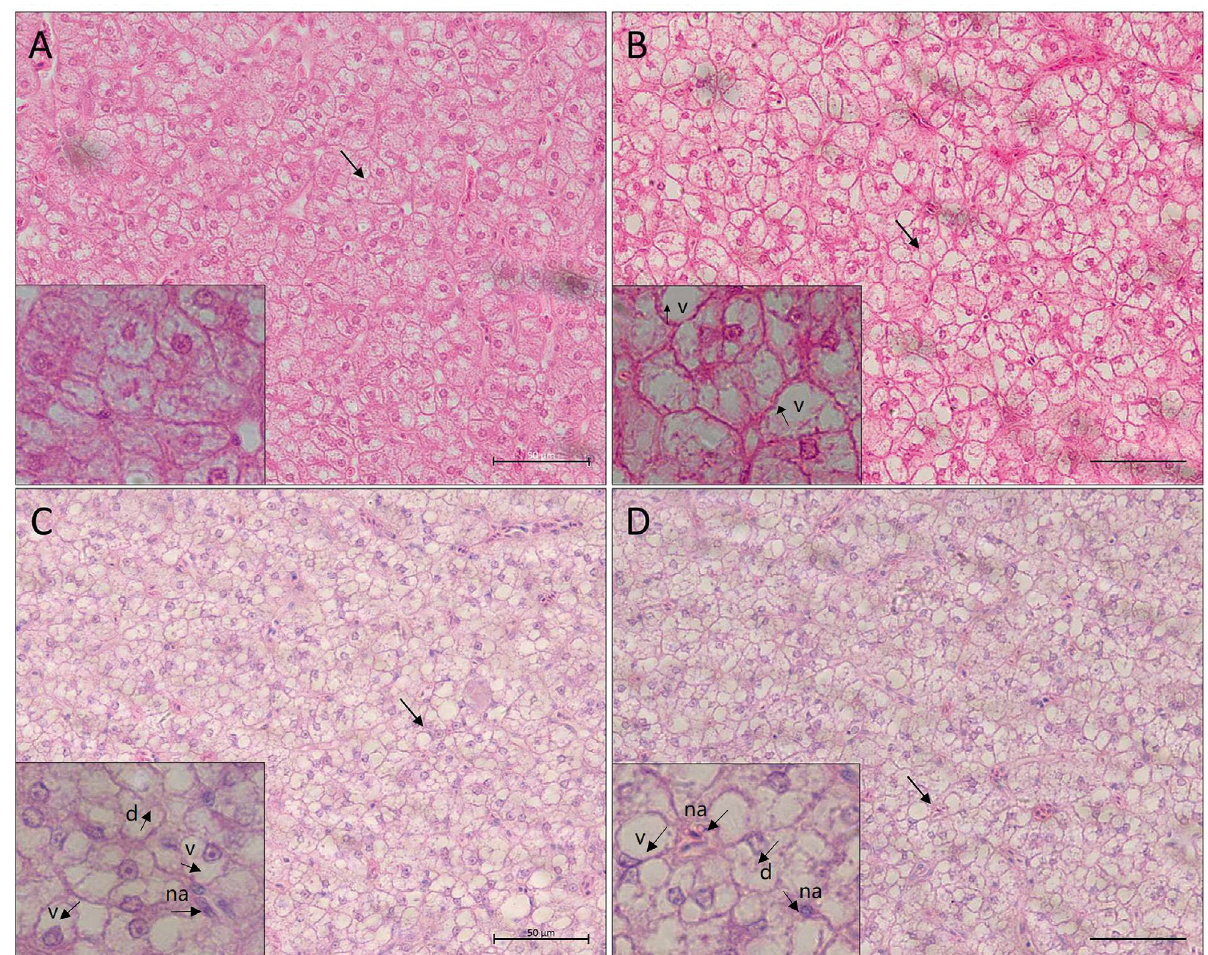
Fig. 2. Histological alterations in the livers of yellow drum subjected to cold and starvation stresses. Analyses were conducted on liver tissues sampled on Day 22 of the experiment from subjects from the (A) 16fed, (B) 16unfed, (C) 8unfed, and (C) 8fed groups. Scale bars: 50 μm. The lower-left corners are zoomed-in areas illustrated by the black arrows. Normal hepato- cytes are shown in (A), and disordered arrangements of liver cells are shown in response to cold and starvation stresses, including vacuolisation, nuclear atrophy and even dissolution. Insets are zoomed-in areas indicated by the black arrows. (v: vacuolisation; na: nuclear atrophy; d: